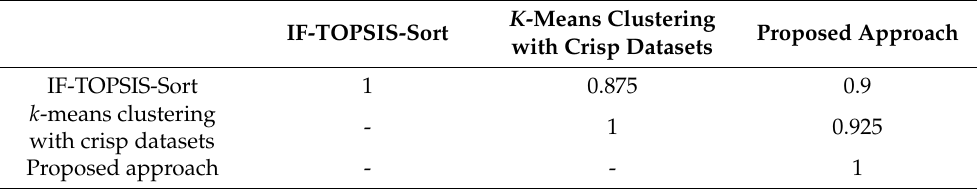
Table 17. Comparing the assignments of tourist sites to clusters with IF-TOPSIS-Sort, k -means clustering with crisp datasets, and the proposed approach based on S r